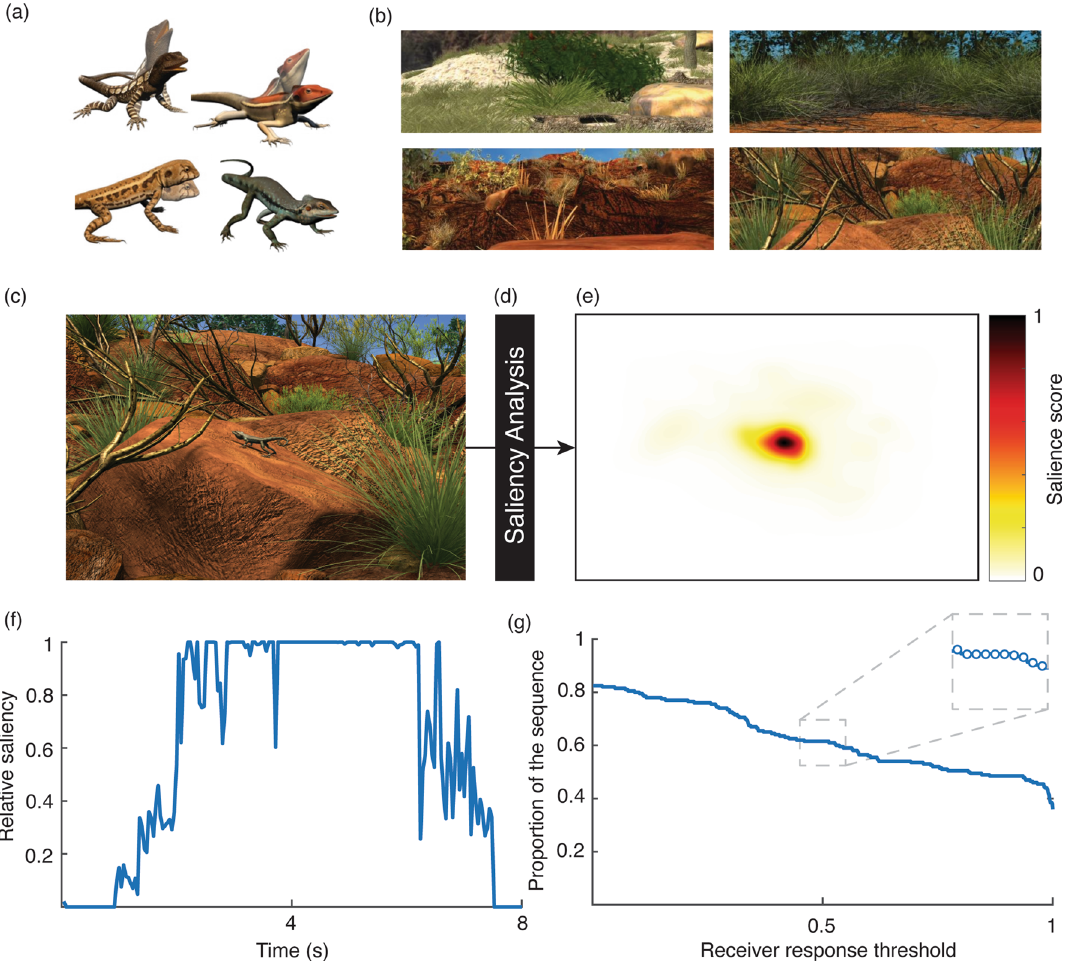
Figure 2. To examine the relative effectiveness of movement-based animal signals we created 3D animations of the displays of four Australian dragon lizards ( a ) and their respective habitats ( b ). Each species was inserted into each habitat ( c ) under varying environmental conditions. Animation sequences were then subjected to saliency analysis ( d ) to compute salience scores for all parts of the scene ( e ). Salience is computed in the range [0,1] and in this example corresponds to the position of the lizard in ( c ). The maximum salience score in the area of the scene featuring the lizard is identified for all frames in the animation sequence ( f ). We assumed the level of salience required to capture attention will vary within and between receivers and determined the proportion of the sequence that exceeded a given threshold as a function of varying receiver response thresholds ( g ). The performance vector comprises discrete scores at small increments in threshold values ( g , inset). Lizard and habitat images were created by the authors using Autodesk Maya 2015 (https:// www. autod esk. com. au/ produ cts/